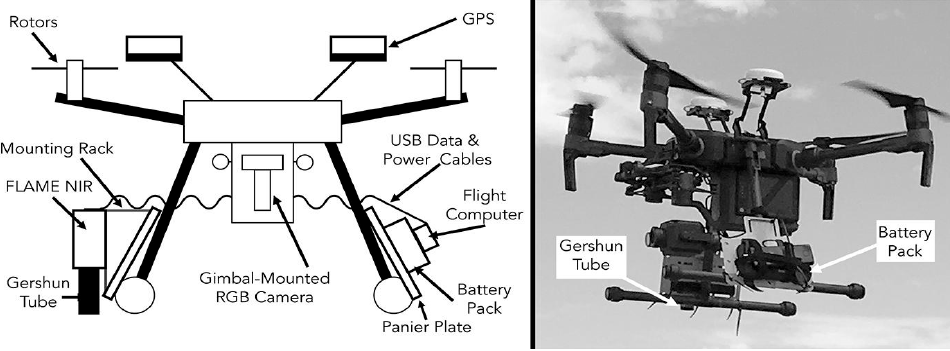
Figure 3. Schematic illustration of the drone-borne spectrometer system. Drone and camera system in flight.